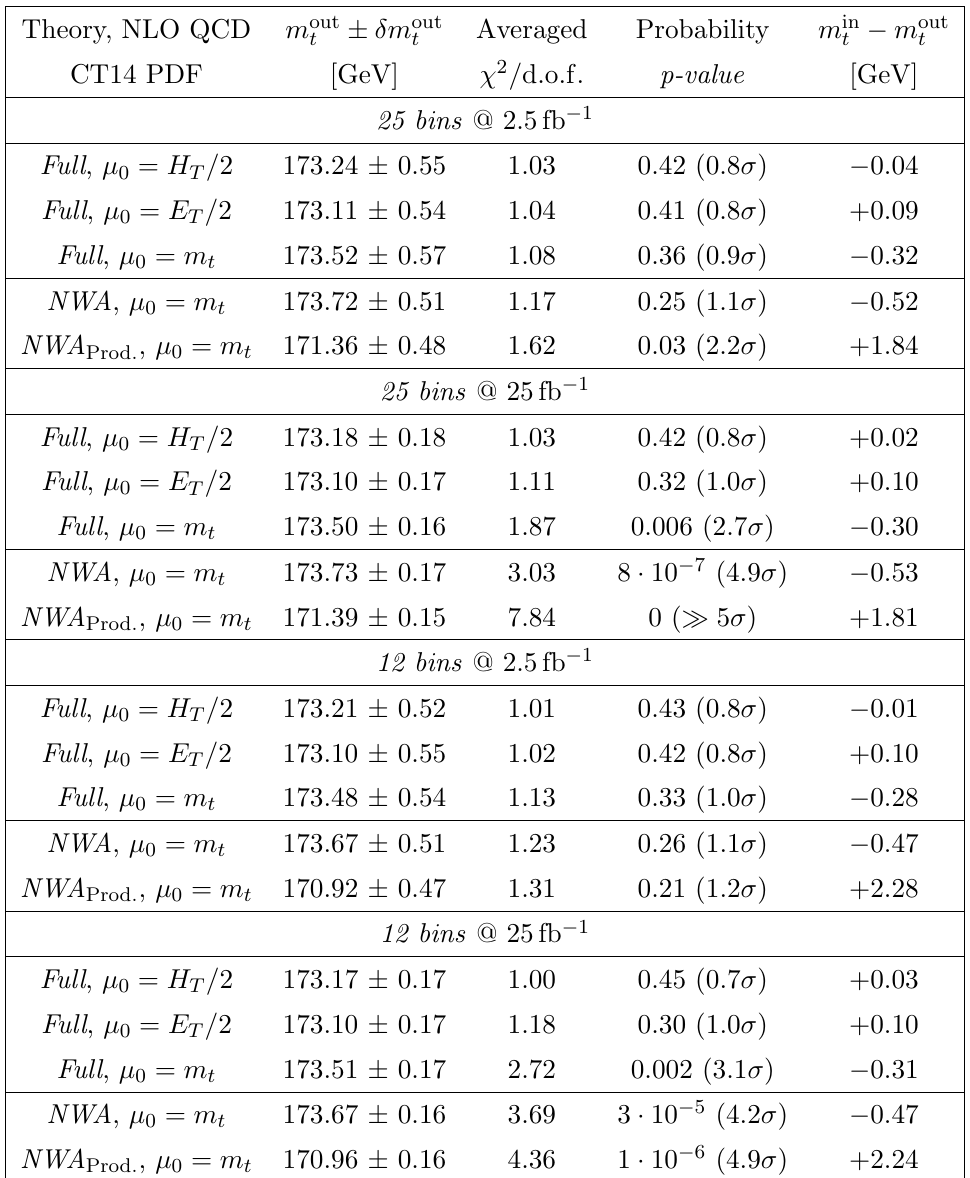
Table 6 . Mean value of the top quark mass, m out , from 1000 pseudo-experiments as obtained from t the normalised M distribution for the pp e + (cid:23) e (cid:22) (cid:0) (cid:22) (cid:23) (cid:22) b (cid:22) bj + X production process at the LHC t (cid:22) t ! with p s = 13 TeV. Also shown is 68 % C.L. (1 (cid:27) ) statistical error of the top quark mass, (cid:14)m out together with the averaged minimal (cid:31) 2 =d:o:f and the p-value. The number of standard deviations corresponding to each p-value is presented in parentheses. In the last column the top quark mass shift, de(cid:12)ned as m in m out , with m in = 173.2 GeV, is also given. Luminosity of 2.5 fb (cid:0) 1 and 25 fb (cid:0) 1 t (cid:0) t t is assumed.